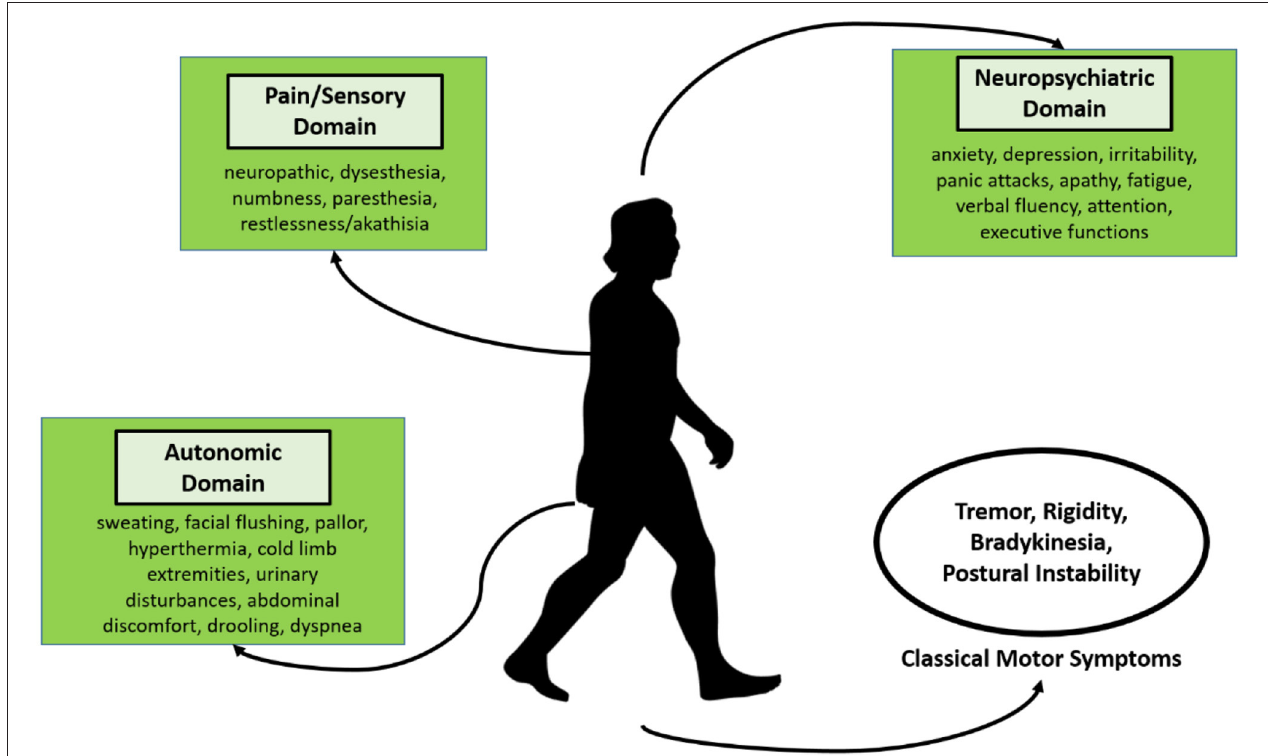
FIGURE 1 | Clinical presentation of PD, according to the motor and non-motor signs and